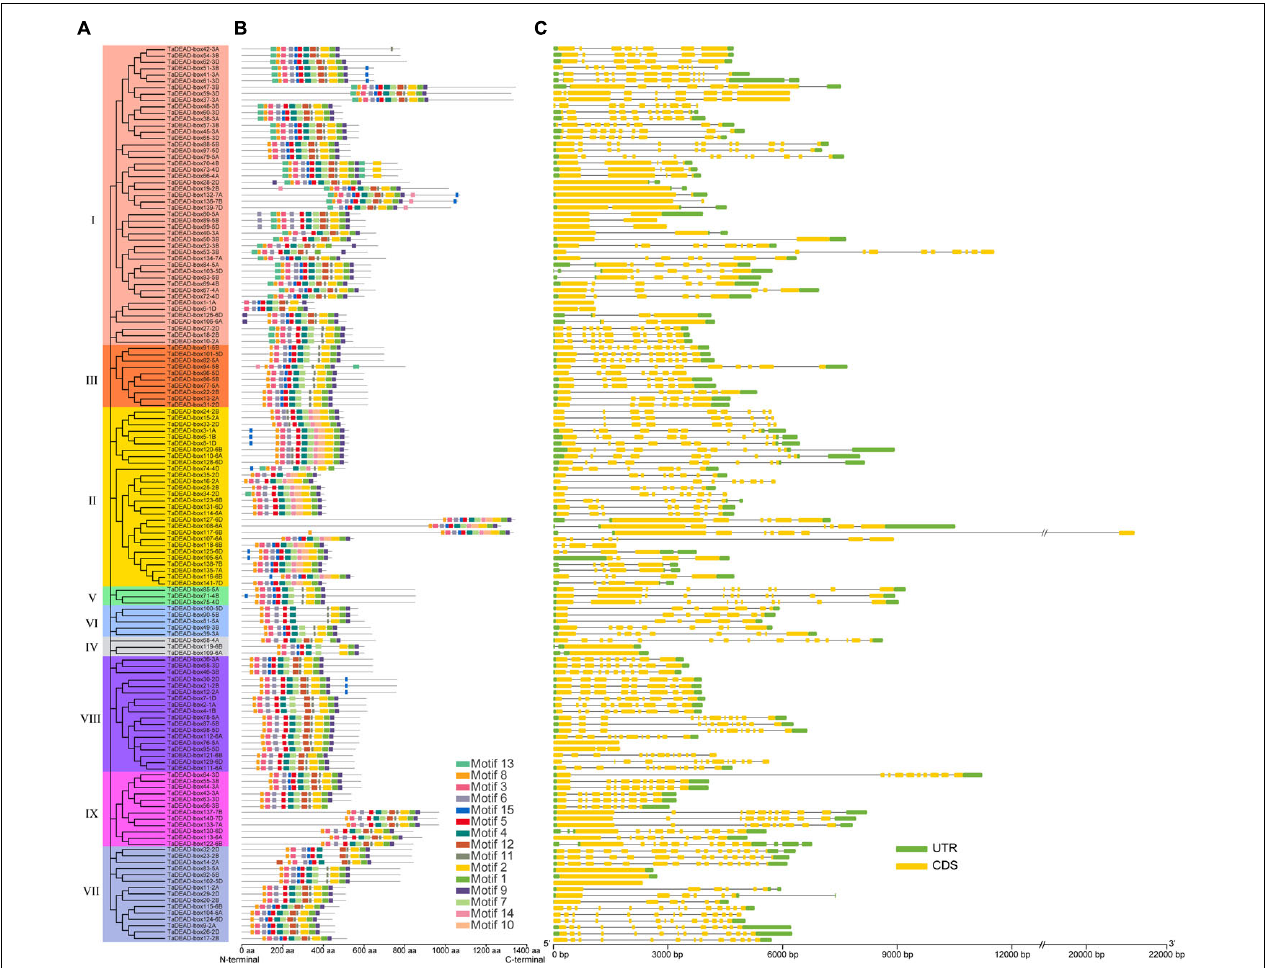
FIGURE 5 | Phylogenetic tree, motif distribution and gene structure analysis of 141 TaDEAD-box members. (A) Phylogenetic tree of DEAD-box members in wheat. A total of 141 TaDEAD-box proteins were used to construct the neighbor-joining (NJ) phylogenetic tree by MEGA X with 1,000 bootstrap replicates. The different groups are marked with different colors. (B) Motif distribution of 141 TaDEAD-box proteins. The different colored boxes represent 15 motifs, and the box lengths represent motif lengths. (C) The exon-intron structure analysis of 141 TaDEAD-box genes. Exon and introns lengths are displayed proportionally, yellow boxes represent exons, black lines represent introns, and green boxes represent 5 (cid:48) and 3 (cid:48) UTR.